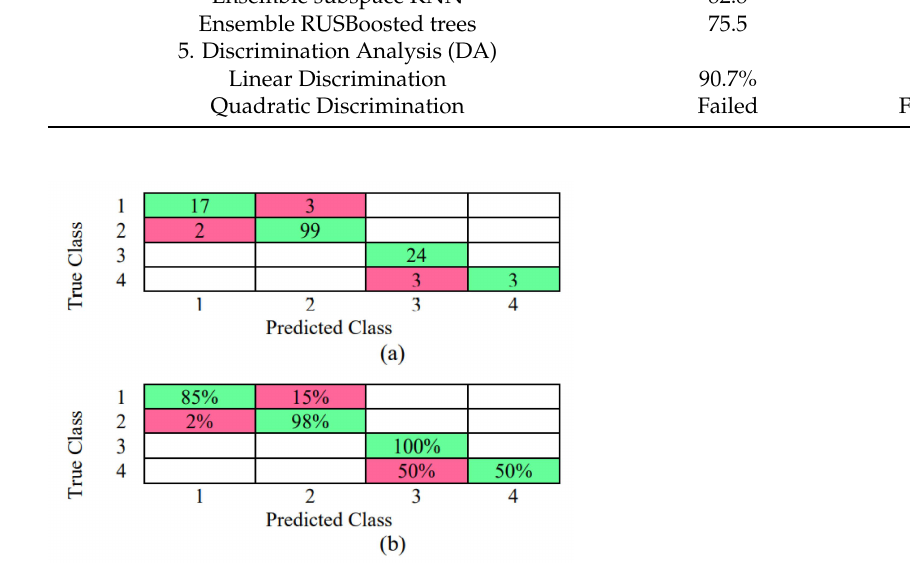
Figure 4. Confusion matrix of linear SVM that was applied to the raw data, (Green refers to True Positive, red refers to False negative) ( a ) corrected prediction samples for each class ( b ) prediction accuracy of each